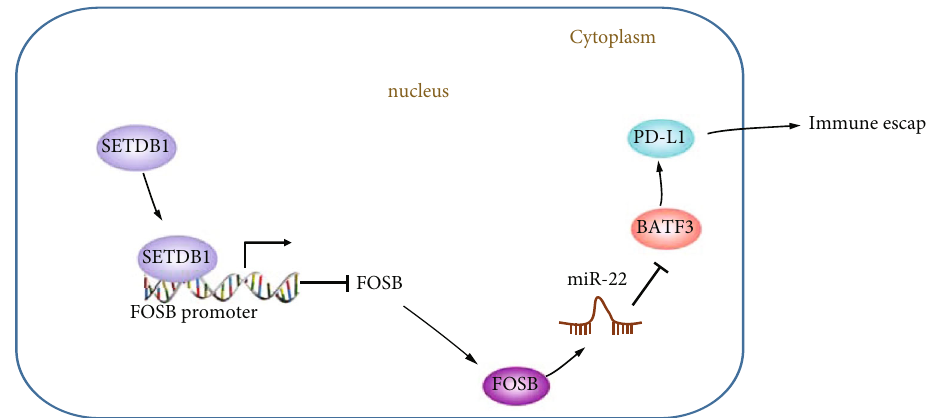
Figure 6: The schematic diagram depicts the molecular mechanism by which SETDB1 stimulates the immune evasion in CRC via the FOSB/miR-22/BATF3/PD-L1 axis. SETDB1 promotes FOSB methylation and inhibits FOSB expression, thereby reducing the expression of miR-22, enhancing BATF3 protein expression, and increasing PD-L1 expression in CRC cells. By this mechanism, SETDB1 augments the proliferation of CRC cells and inhibits their apoptosis as well as attenuating the killing e ff ect of T cells on tumors, thereby favoring the immune escape of